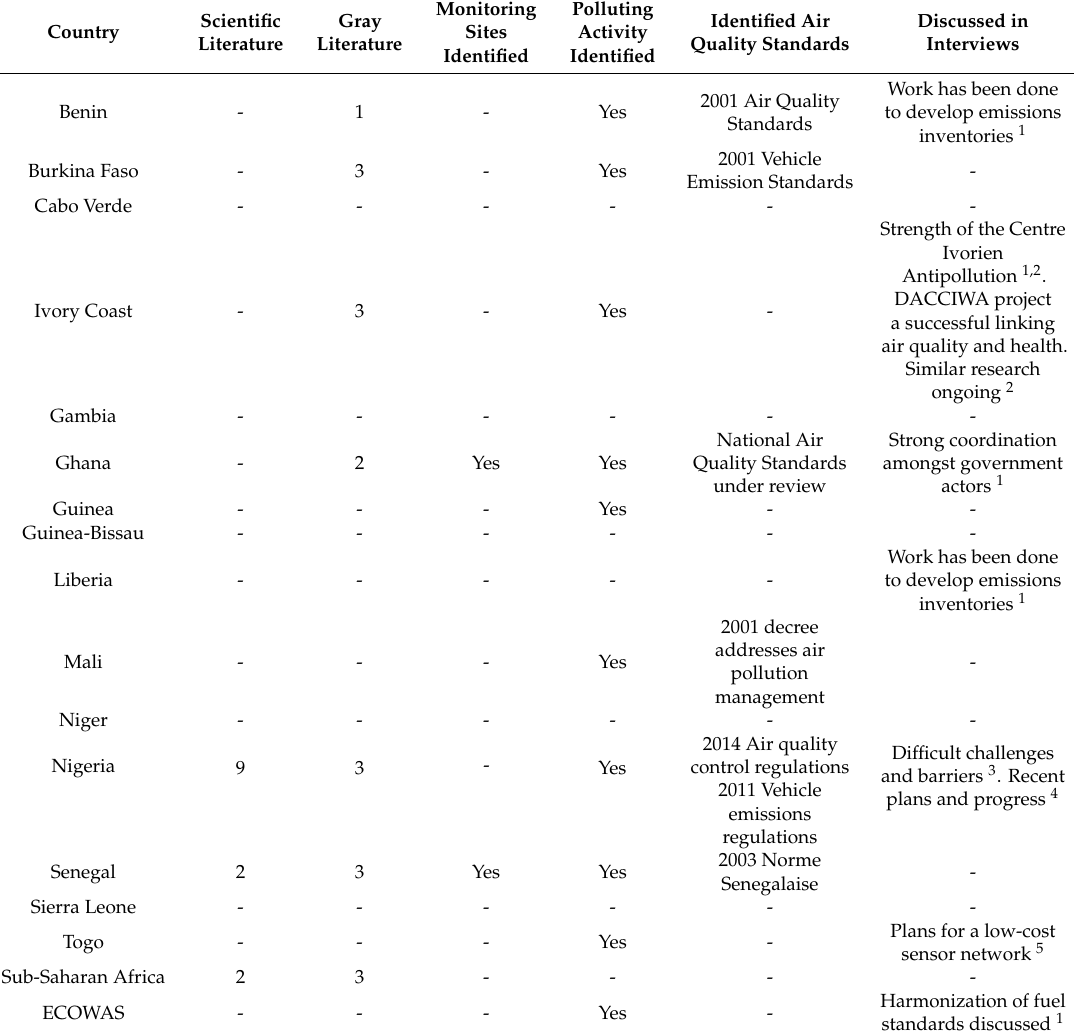
Table 3. Summary of studies and regulations included for review, per country and region.